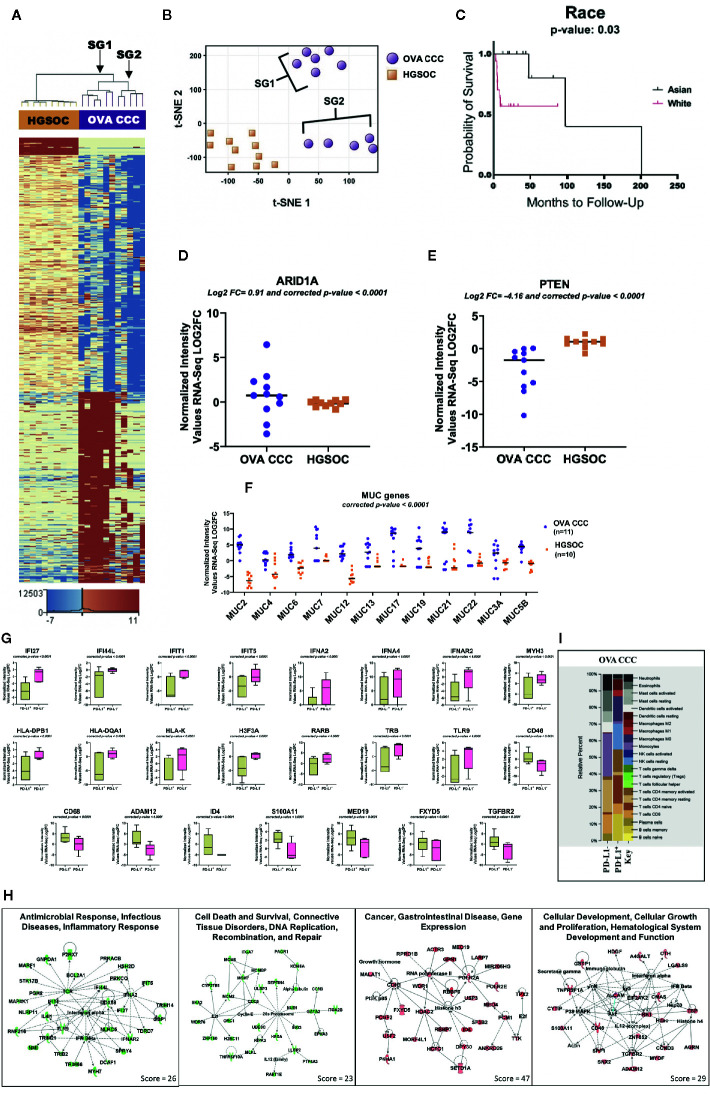
RNA-seq analysis of clear cell ovarian cancer. (A) Eleven clear cell ovarian carcinoma specimens were compared to ten high grade serous ovarian cancer patients (HGSOC). 1,212 genes were upregulated and 1,613 genes downregulated in ovarian CCCs compared to HGSOC (corrected p-value < 0.05, |FC| ≥ 10). Two distinct subgroups (SG1 and SG2) are revealed. (B) A non-linear dimension reduction (t-SNE) 2D plot on the 2,825 statistically differentially expressed genes in ovarian CCC and HGSOC revealed the same two distinct subgroups as in (A). Orange squares are HGSOC. (C) Kaplan–Meier curve for 11 Asian and 19 White patients with ovarian CCC displaying the effects of race on ovarian cancer overall survival. (D, E) Log2 expression levels of tumor suppressor genes ARID1A and PTEN in eleven ovarian CCCs and ten HGSOC patients. (F) Scatter plot of the expression of mucin gene families. Mucin gene family were expressed at significantly higher levels (p < 0.0001) in ovarian CCC than in HGOC. (G) Box plots depicting the expression levels of significantly differentially transcribed genes (corrected p < 0.0001, |FC| ≥8) in PD-L1 CPS+ patients (n = 6) compared to PD-L1 CPS− patients (n = 5). (H) Four top ranked gene networks of up and downregulated genes in PD-L1+ as compared to PD-L1− ovarian CCC patients. Green colored nodes indicate downregulated and red indicates upregulated gene expression in PD-L1+ versus PD-L1− ovarian CCC cases. Darker shades of the nodes indicate higher expression values. Solid lines represent direct interactions. Dotted lines represent indirect interactions. White colored nodes are in the pathway, but not in our dataset. (I) CIBERSORT analysis of 22 immune cell types in PD-L1 positive (n = 6) and negative ovarian CCC (n = 5) cohorts (1,000 permutations). (OVA CCC, ovarian clear cell carcinoma; HGSOC, high grade serous ovarian cancer; FC, fold change; OS, overall survival; PD-L1, programmed death ligand 1; SG1, subgroup 1); SG2, subgroup 2.